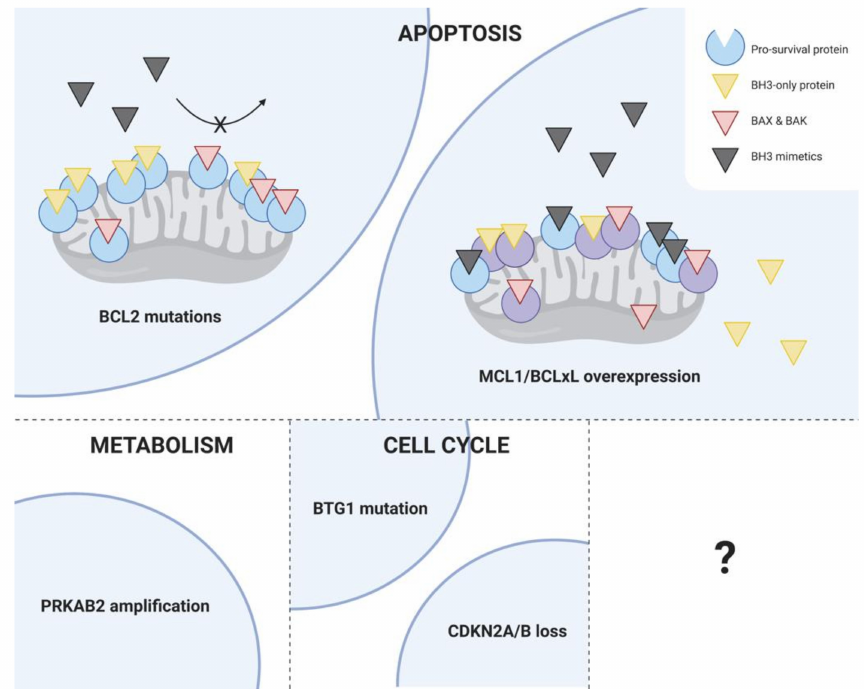
Figure 3. Mechanisms of acquired resistance to venetoclax in CLL. Although the factors contributing to disease progression on venetoclax are still the subject of ongoing research, available studies have identified a diverse range of mechanisms, which broadly target three cellular processes: apoptosis, metabolism, and the cell cycle. The most common recurrent mechanism of venetoclax resistance identified in CLL to date is the acquisition of the BCL2 G101V mutation, although other BCL2 mutations have also been detected (e.g., D103Y, D103E, D103V, V156D, R107_R110dup, A113G, R129L). Other mechanisms include the upregulation of alternative pro-survival proteins, particularly MCL1 and BCLxL, amplification of a positive regulatory subunit of AMPK called PRKAB2, leading to increased oxidative phosphorylation, homozygous deletions of CDKN2A / B , and BTG1